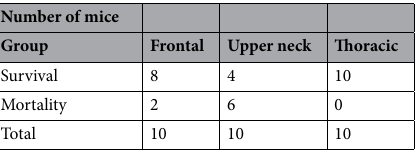
Table 1. Comparison of post-LISW survival rates. Survival rates: Frontal group, 80%; Upper neck group, 40%; Thoracic group, 100%.